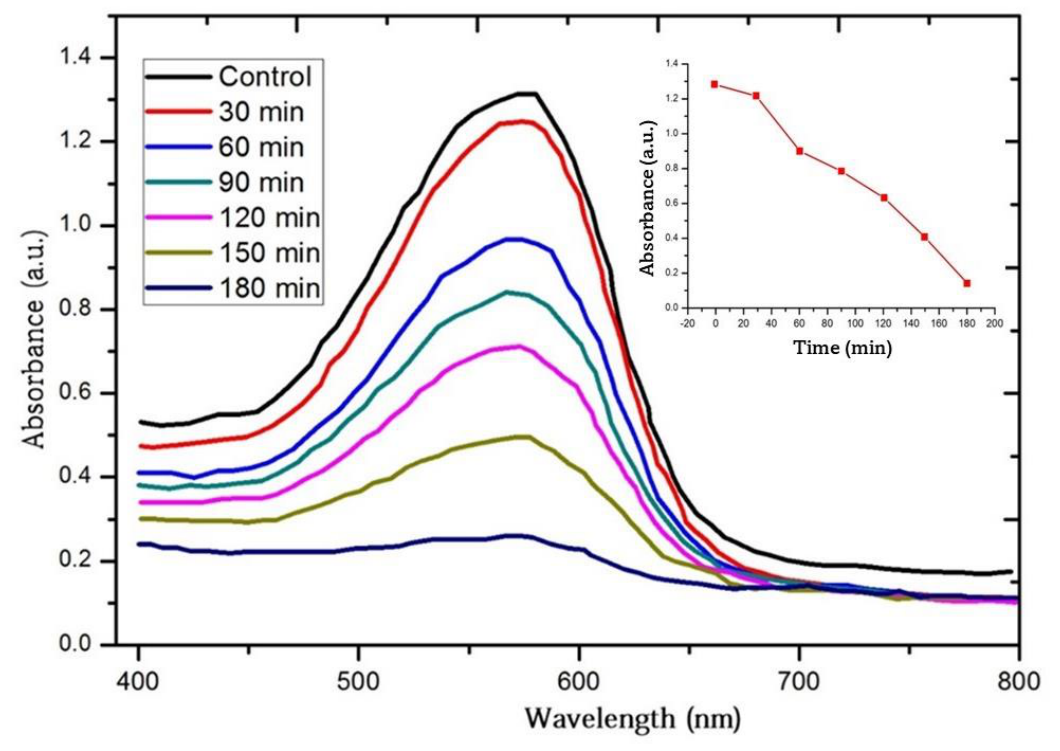
Figure 8. UV-vis absorption spectra showing the degradation of textile Orange 16 reactive dye by photocatalytic action using zinc oxide NPs synthesized via the green route at 30 min time intermissions. Inset: decrease in intensity of textile Orange 16 reactive dye in the presence of ZnO-NPs with time.